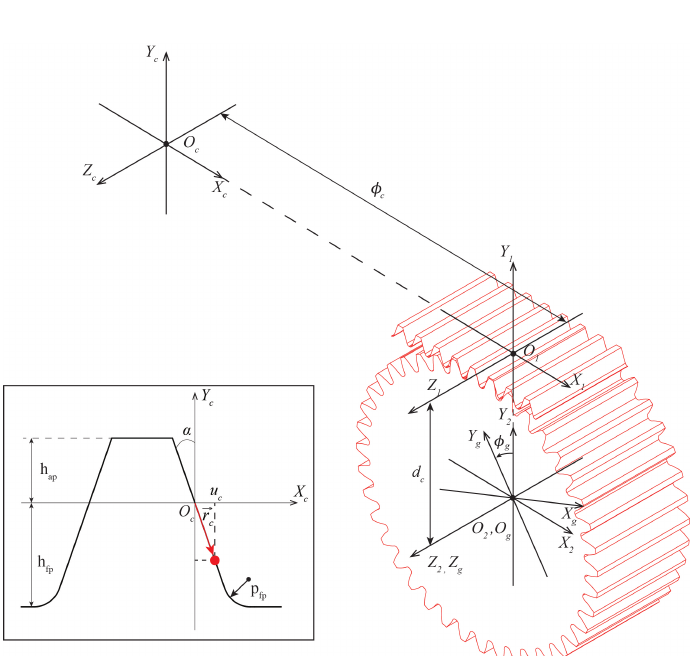
Figure 1. Relationship between the coordinate systems C c and C g of the rack cutter and the spur gear,